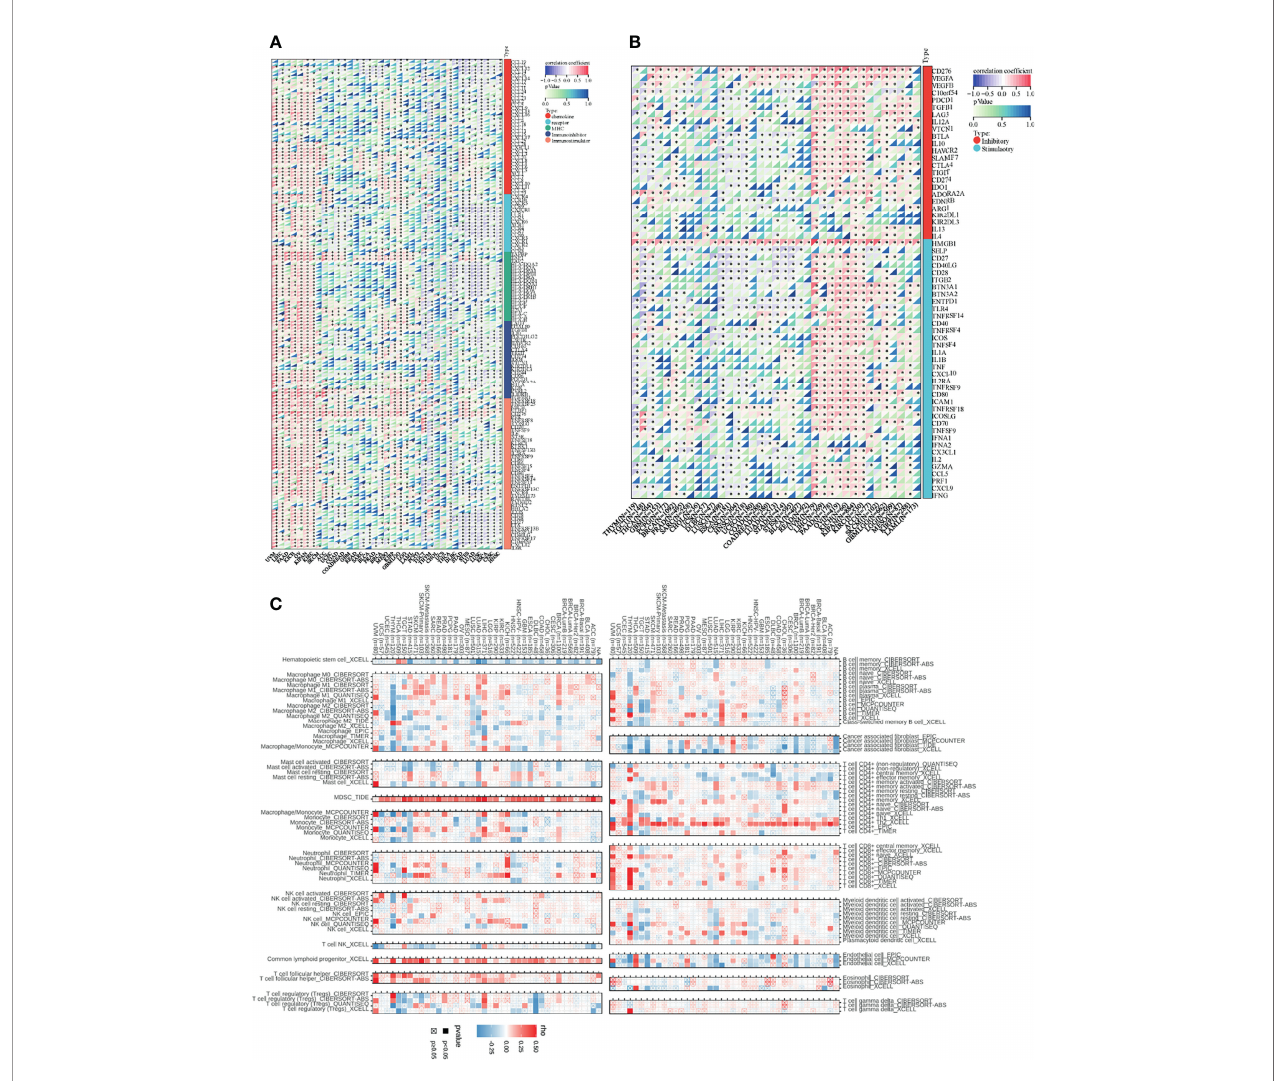
FIGURE 7 | Association between SNRPA1 and tumor immunity in pan-cancer. (A, B) Correlations of SNRPA1 expression with immune moderator genes and immune checkpoint-related genes in 33 cancer types. (C) Correlation between SNRPA1 expression and immune cell in fi ltration via multiple